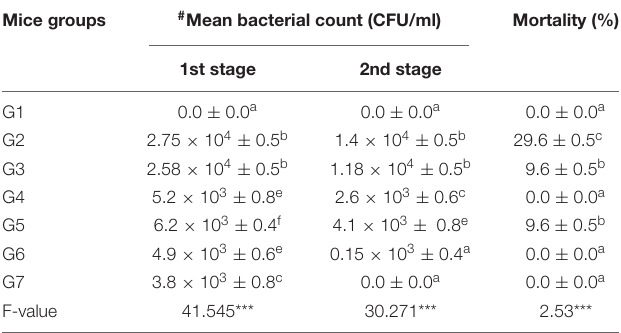
TABLE 2 | Bacterial skin count and mortality of various groups examined under different treatment conditions. Mice